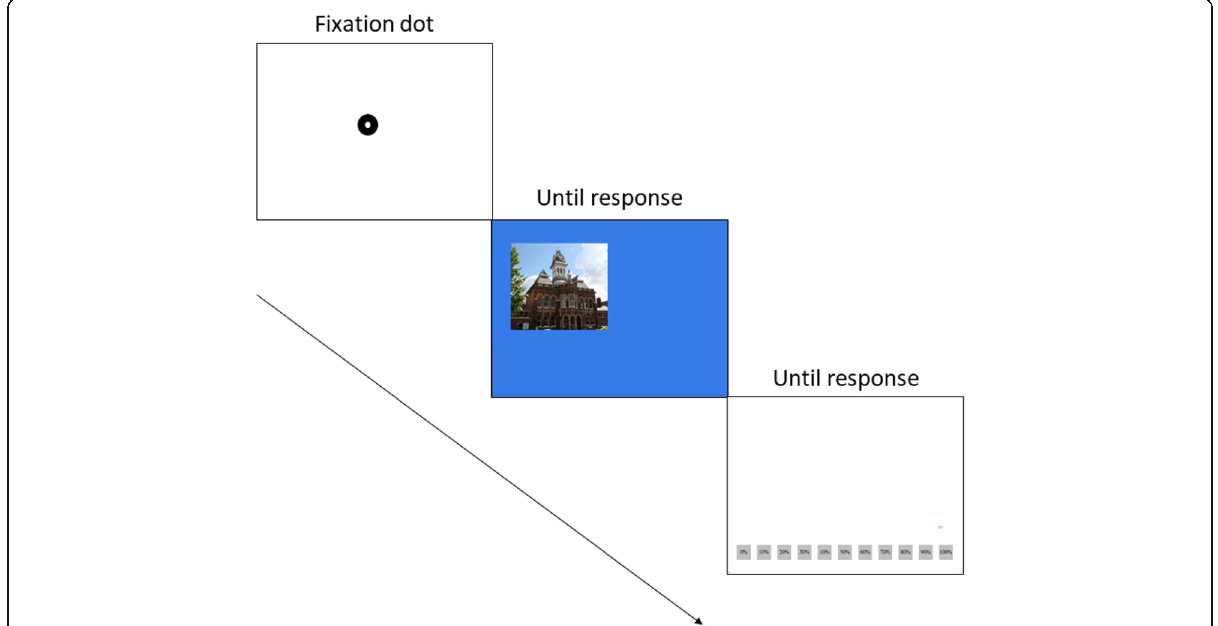
Fig. 1 An example of one full trial sequence. The trial commenced with a drift correction followed by a photograph for recognition (the picture depicted here is a personally familiar place, the city guildhall), followed by a confidence scale (0 – 100%). In one block, the participant